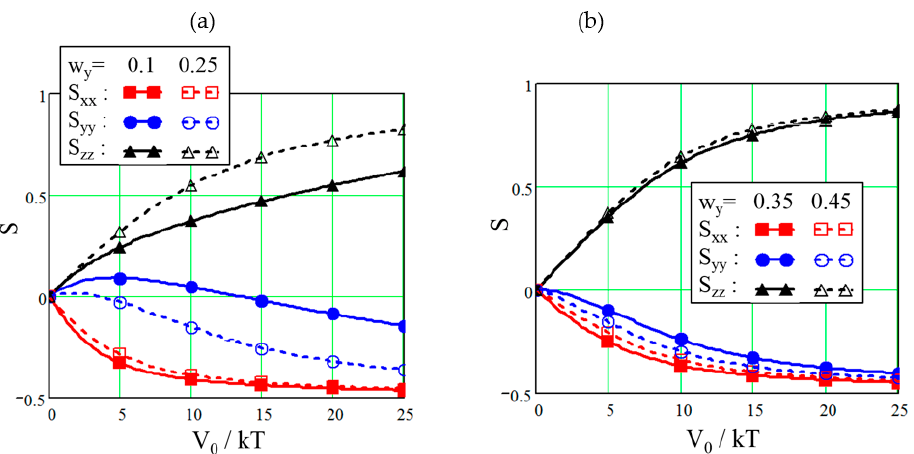
Figure 2. Components of the order parameter tensor S ββ as functions of the parameter V 0 /kT at w y = 0.1; 0.25 ( a ) and at w y = 0.35; 0.45 ( b ).